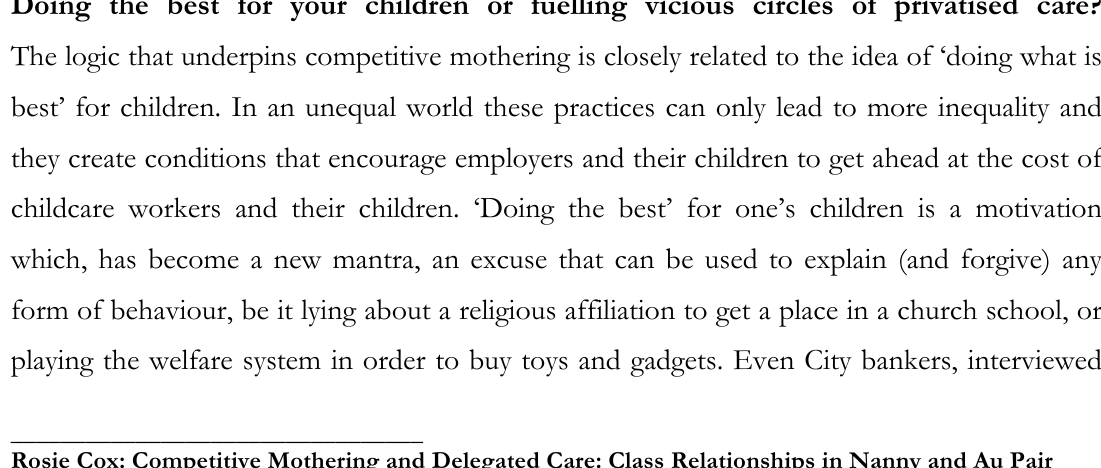
Rosie Cox: Competitive Mothering and Delegated Care: Class Relationships in Nanny and Au Pair